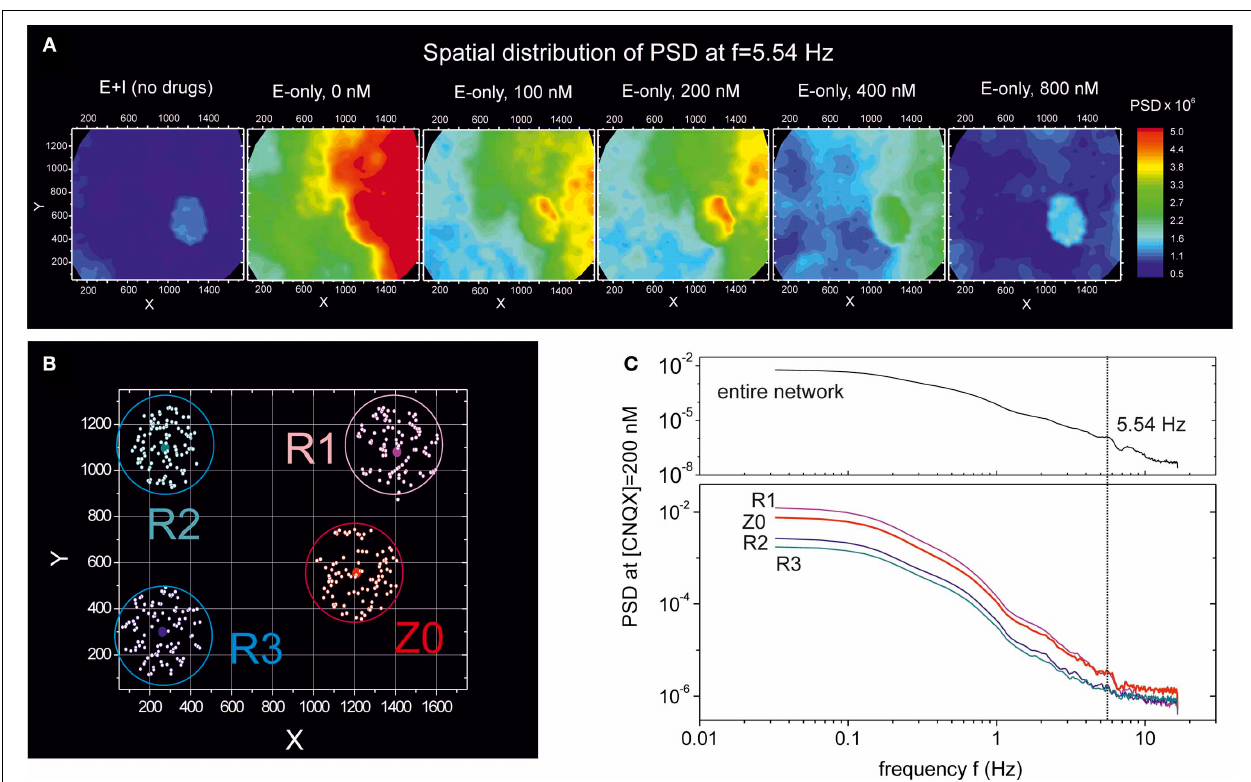
FIGURE 8 | Emergence of synchronous oscillations during network disintegration through CNQX. Data corresponds to the experiment at DIV 16 shown in Figure 6C . (A) Spatial distribution of the PSD at a frequency of 5 . 54Hz and for different connectivity conditions, “E + I” and “E-only” with gradual weakening. The presence of a compact spot at the center-right of the PSD map highlights a neuronal community (termed Z0) that synchronously oscillates at this frequency. Oscillations with strong amplitude also appear along the right edge. For [ CNQX ] = 200nM the Z0